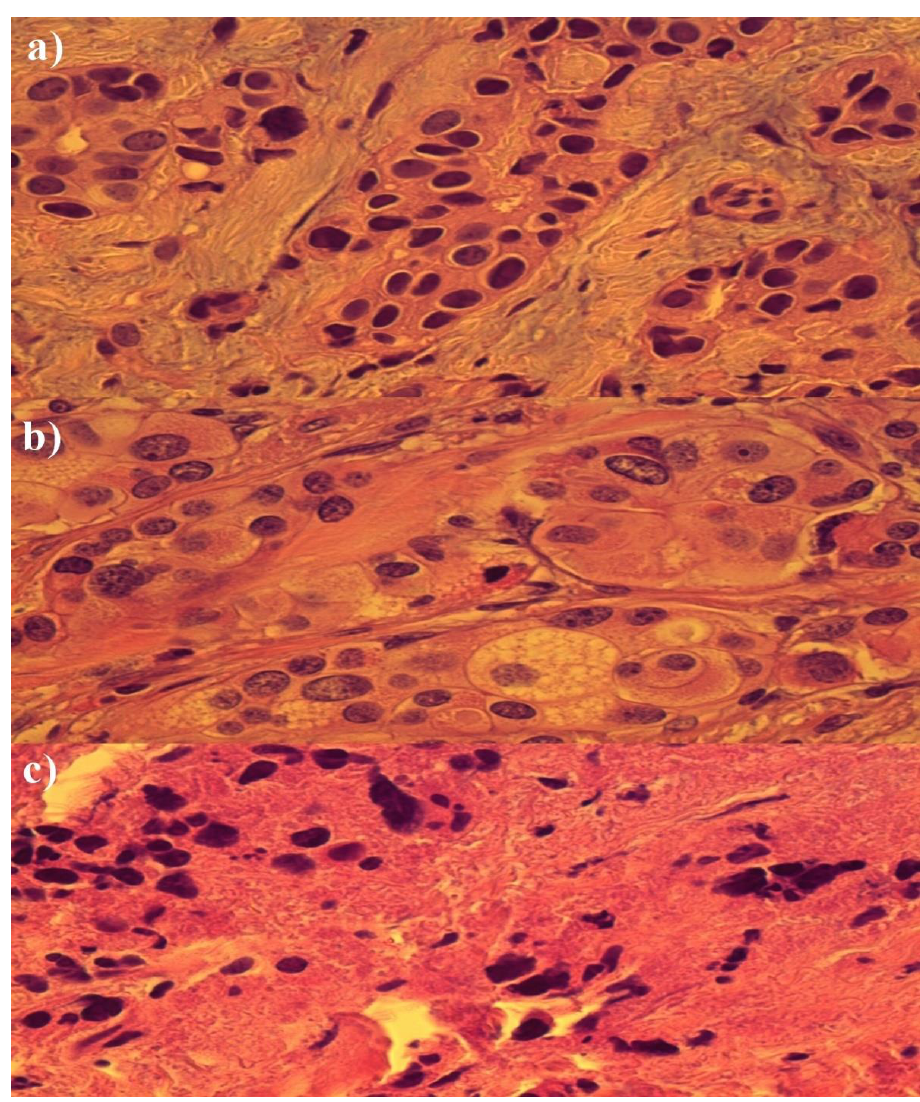
Figure 3. Histopathological image of breast cancer tissue, ( a ) before chemotherapy, ( b ) after chemotherapy, ( c ) after chemotherapy and photodynamic action.